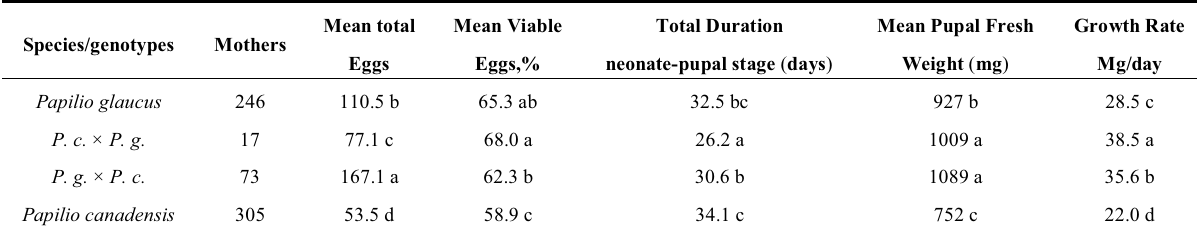
Table 1. Hybrid vigor in swallowtail butterfly sister species. Data from Scriber lab 1982 (cid:177) 2003. Significant differences indicated by different letters at the p = 0.05 level